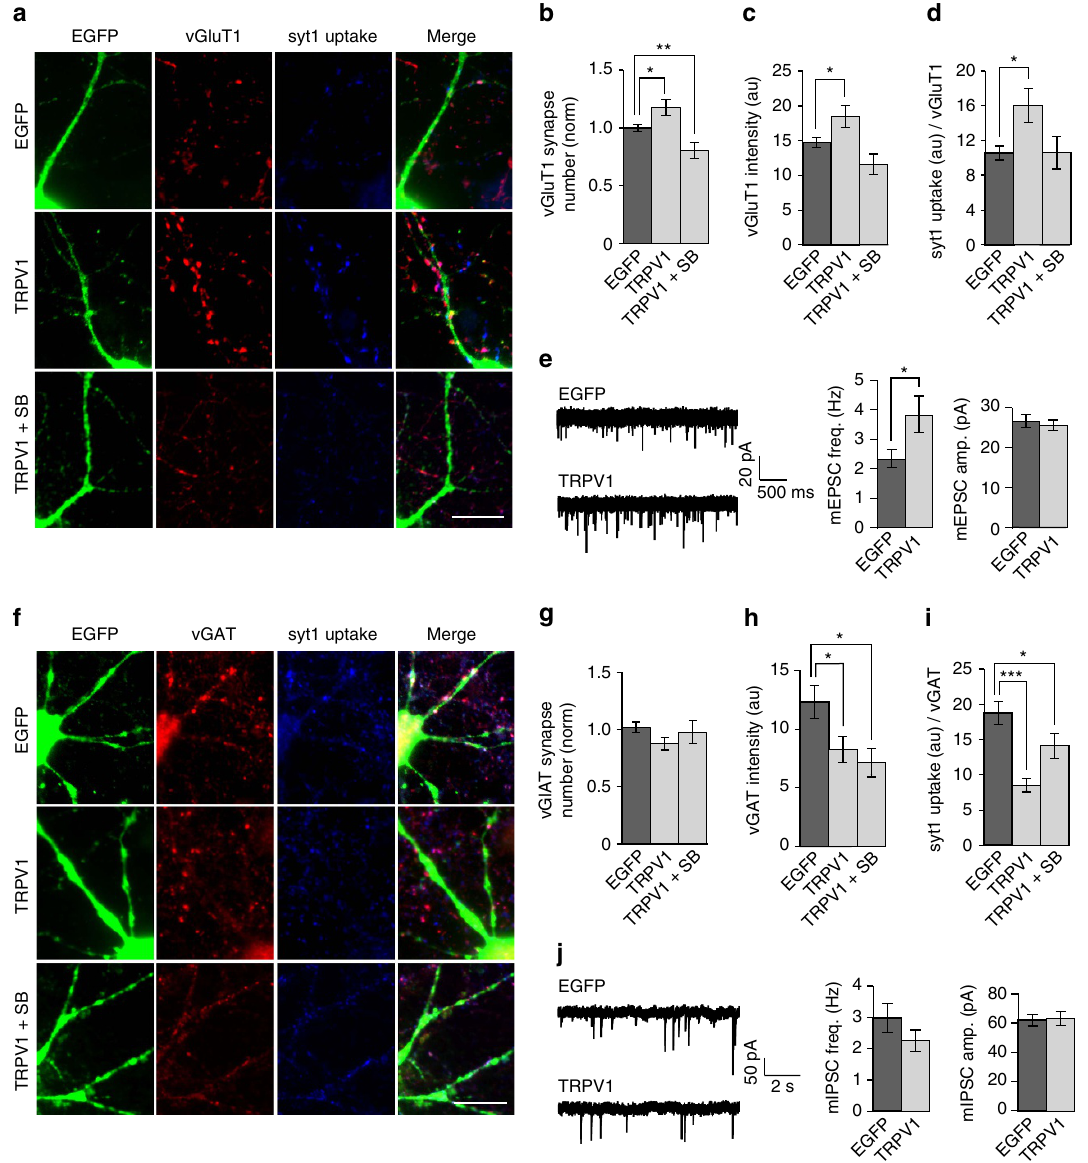
Figure 7 | TRPV1 overexpression in neurons increases excitatory innervation. ( a ) Immunostains of TRPV1-IRES-GFP and EGFP transfected neurons in the indicated conditions with vGluT1 and lumenal syt1 antibody internalized by recycling synaptic vesicles during depolarization; scale bars, 10 m m. ( b ) Quantitation of excitatory synapse number (number of vGluT1 puncta) on TRPV1-expressing cells with and without treatment with 1 m M SB-366791 to block TRPV1 channels, compared to EGFP controls. ( c ) Quantitation of vGluT1 signal intensity (corresponding to number of vGluT1 vesicles per terminal) in the indicated conditions. ( d ) Quantitation of lumenal syt1 antibody uptake in depolarizing conditions (corresponding to the total number of recycling synaptic vesicles in excitatory terminals) in vGluT1-positive terminals (neurons/images quantified were: EGFP n ¼ 60, TRPV1-IRES-GFP n ¼ 30, TRPV1- IRES-GFP þ 1 m M SB-366791 DIV4 n ¼ 15; from 5 to 20 different neuronal cultures). ( e ) TRPV1-IRES-GFP-expressing neurons have increased mEPSC frequency compared to control EGFP-expressing neurons, and unchanged amplitude, consistent with an increase in synapse number in TRPV1-over- expressing neurons (cells used for analysis: EGFP n ¼ 29, TRPV1-IRES-GFP n ¼ 27). ( f ) Immunostain of TRPV1-IRES-GFP or EGFP transfected neurons in the indicated conditions with vGATand syt1 internalized by recycling synaptic vesicles during depolarization; scale bars, 10 m m. ( g ) Quantitation of inhibitory synapse number (number of vGAT puncta) on TRPV1-expressing cells with and without treatment with 1 m M SB-366791 to block TRPV1 channels, compared to EGFP. ( h ) Quantitation of vGAT signal intensity (corresponding to number of vGAT vesicles per terminal). ( i ) Quantitation of lumenal syt1 antibody uptake in depolarizing conditions (corresponding to the total number of recycling synaptic vesicles in inhibitory terminals) in vGAT-positive terminals (neurons/images quantified were: EGFP n ¼ 60, TRPV1-IRES-GFP n ¼ 27, TRPV1-IRES-GFP þ 1 m M SB-366791 DIV4 n ¼ 15; from five cultures). ( j ) TRPV1-IRES-GFP-expressing neurons have no change in mIPSC frequency or amplitude, compared to control EGFP-expressing neurons (cells used for analysis: EGFP n ¼ 27, TRPV1-IRES-GFP n ¼ 24). Error ¼ s.e.m.; significance determined by unpaired Student’s t -test * P o 0.05, ** P o 0.01, *** P o 0.001. NATURE COMMUNICATIONS|8:15878|DOI: